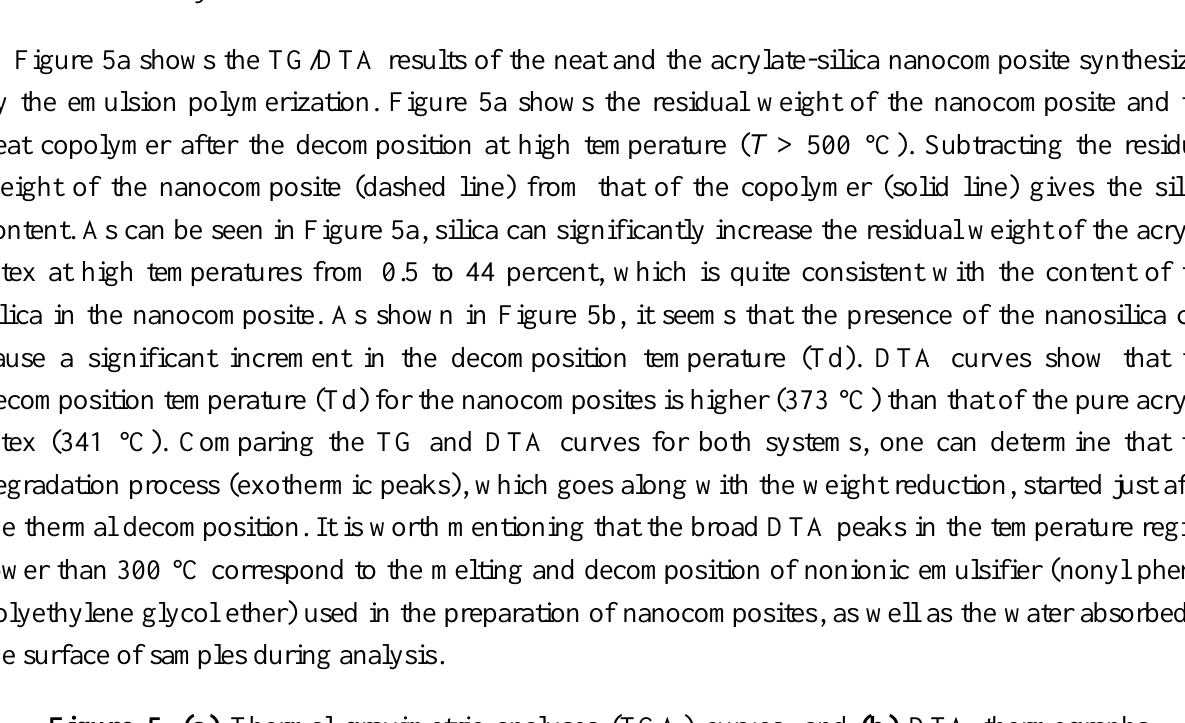
Figure 5. (a) Thermal gravimetric analyses (TGA) curves; and (b) DTA thermographs nanocomposite (dashed line) and plain copolymer (solid